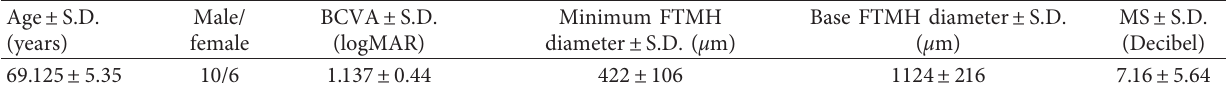
Table 1: Mean preoperative patients’ characteristics.